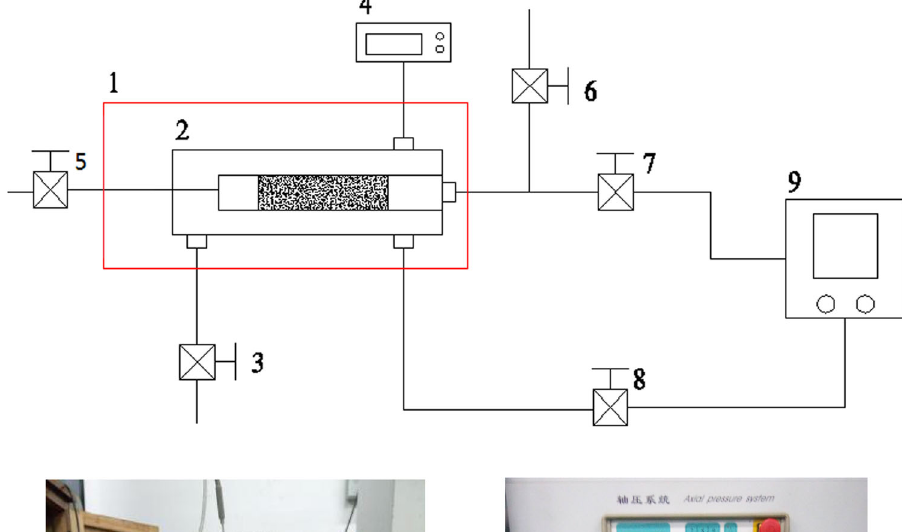
Fig. 2 Experimental equipment of compression coefficient. a Core holder, b EDC servo control system, c temperature control instrument, d copper